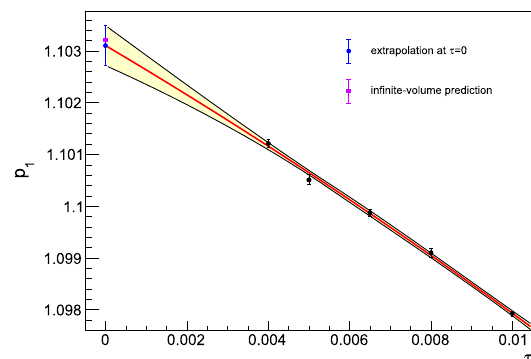
Fig. 5 In the left panel, signal samples of the coefficient p 39 taken from a 8 4 lattice with TBC in three directions. The simulation with Wilson fermions has been performed for illustrative reasons and the bare mass has been set to zero. In the right panel, signal samples of the coefficient p 36 with TBC on a plane and staggered fermions. In both panels τ = 0 . 005 and the origin of t is set arbitrarily. It is evident that in